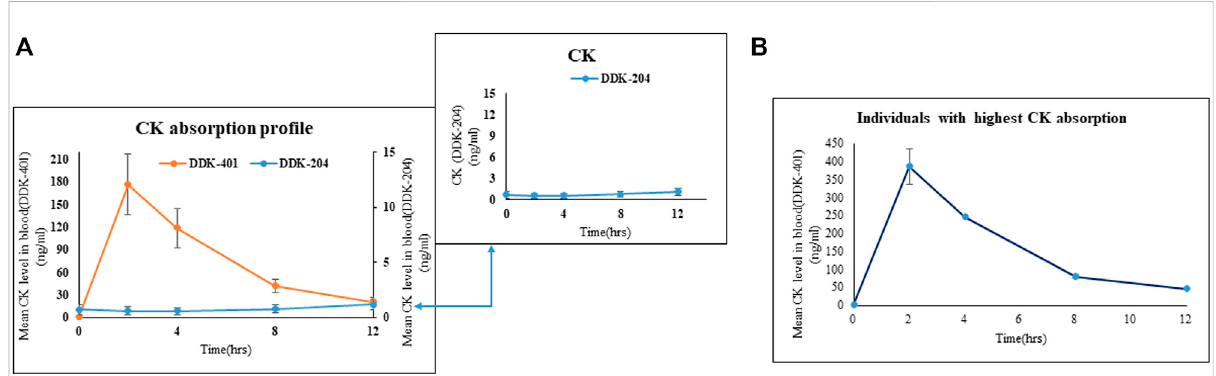
FIGURE 2 Absorptionpro fi lesofCKinhumanbloodafteroralintakeoffermentedredginsengextract(DDK-401)andredginsengextract(DDK-204). (A) MeanCK